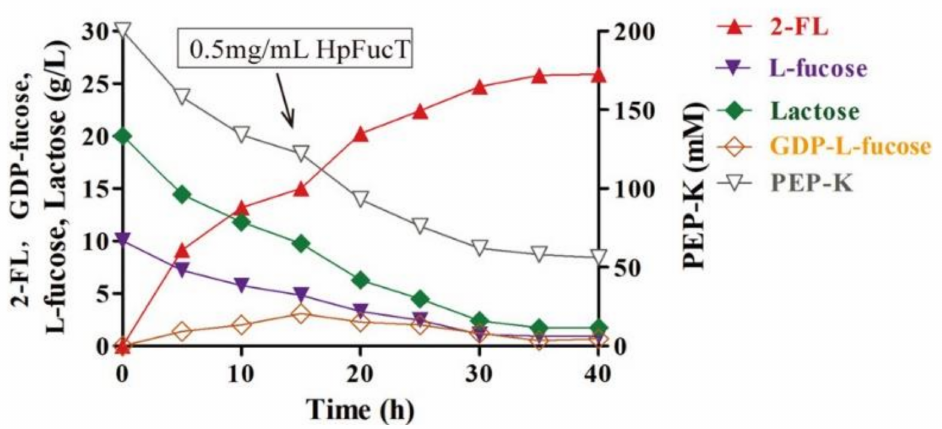
Figure 6. Productivity curve for the synthesis of 2-Fl (red triangle) in the presence of multiple enzymes. The second addition of fucosyltransferase is indicated by an arrow. The depletion of L-fucose (blue triangle), lactose (green diamond), PEP-K (open triangle), and the formation of GDP- fucose intermediate (open diamond) during the reaction are shown. Only L-fucose and lactose as starting substrates are shown, whereas GTP and ATP are constantly recycled by pyruvate kinase during the reaction, resulting in reduced feedback inhibition and savings due to expensive cofactors (reproduced from [37] with permission from The American Chemical